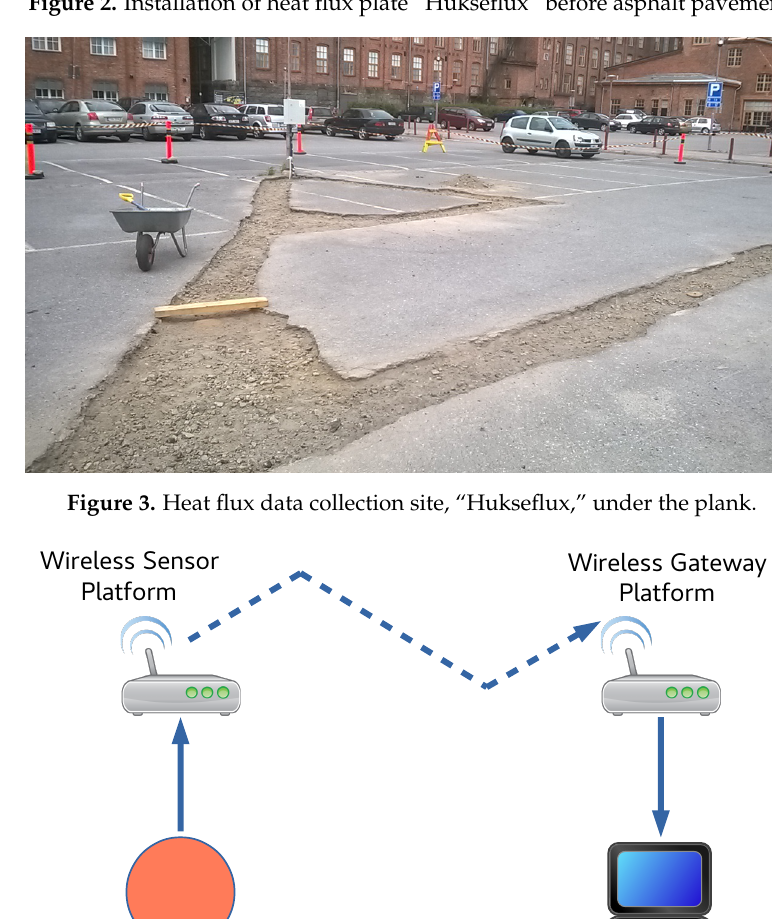
Figure 2. Installation of heat flux plate “Hukseflux” before asphalt pavement.